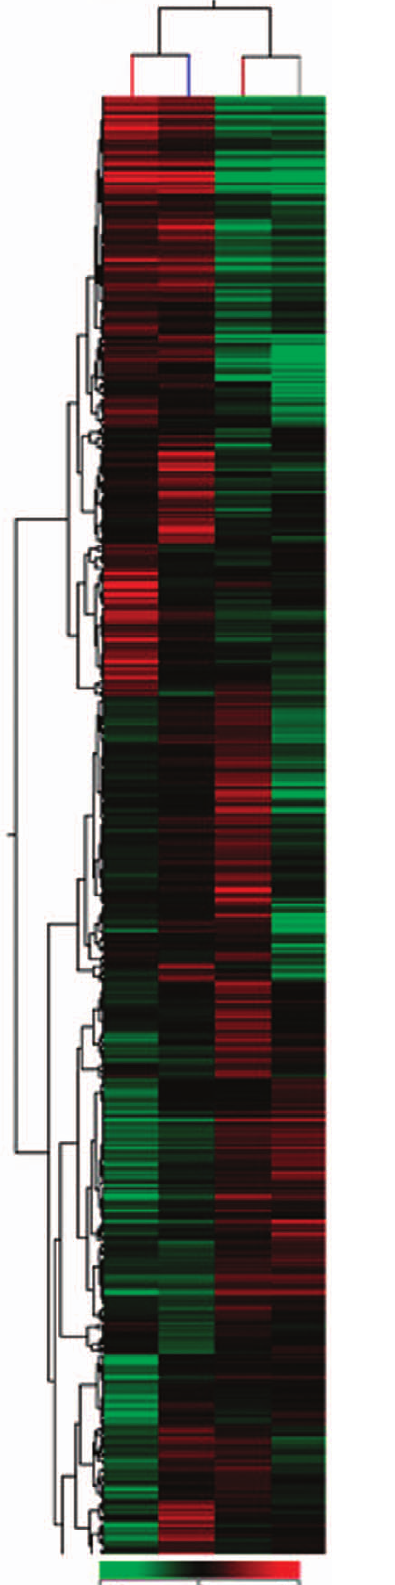
Figure 3. Modulation of mRNAs as evaluated by microarrays. Hierarchical clustering and color heat-map of the transcriptome (mRNAs) of thymocytes isolated from 28-day-old DBA-1/J and DBA-2/J mice and CD3 + T cells from the spleen and lymph nodes of 4-week-old mice from both strains based on microarray expression profiling. The dendrogram and heat-map were obtained using cluster and tree-view algorithms through Agilent GeneSpring platform. This figure shows the modulation of genes related to immune system based on Gene Ontology (GO terms). Heat map legend: Red=up regulation, green=- down regulation, black=unmodulated (Pearson correlation metrics). Sample dendrogram legend: red-line=Naı¨ve T cell DBA-1/J; blue- line=Naı¨ve T cell DBA-2/J; brown-line=Thymocytes DBA-1/J; gray- line=Thymocytes